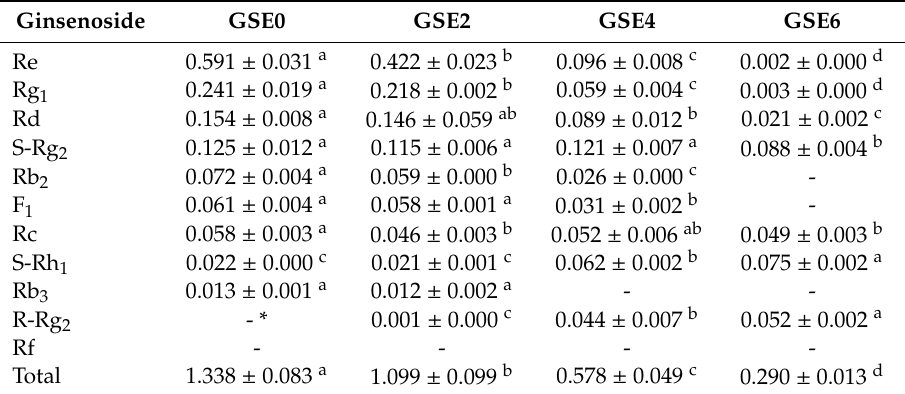
Di ff erent letters within individual rows indicate significant di ff erences at p < 0.05 based on Duncan’s multiple range test. Data are means ± SD ( n = 3). The order of ginsenosides from top to bottom is based on the contents of individual ginsenosides in GSE0 from high to low. Among the ginsenosides listed, Rd, Rb 2 , Rc, and Rb 3 are protopanaxadiols, while Re, Rg 1 , S-Rg 2 , F 1 , S-Rh 1 , R-Rg 2 , and Rf are protopanaxatriols. * not